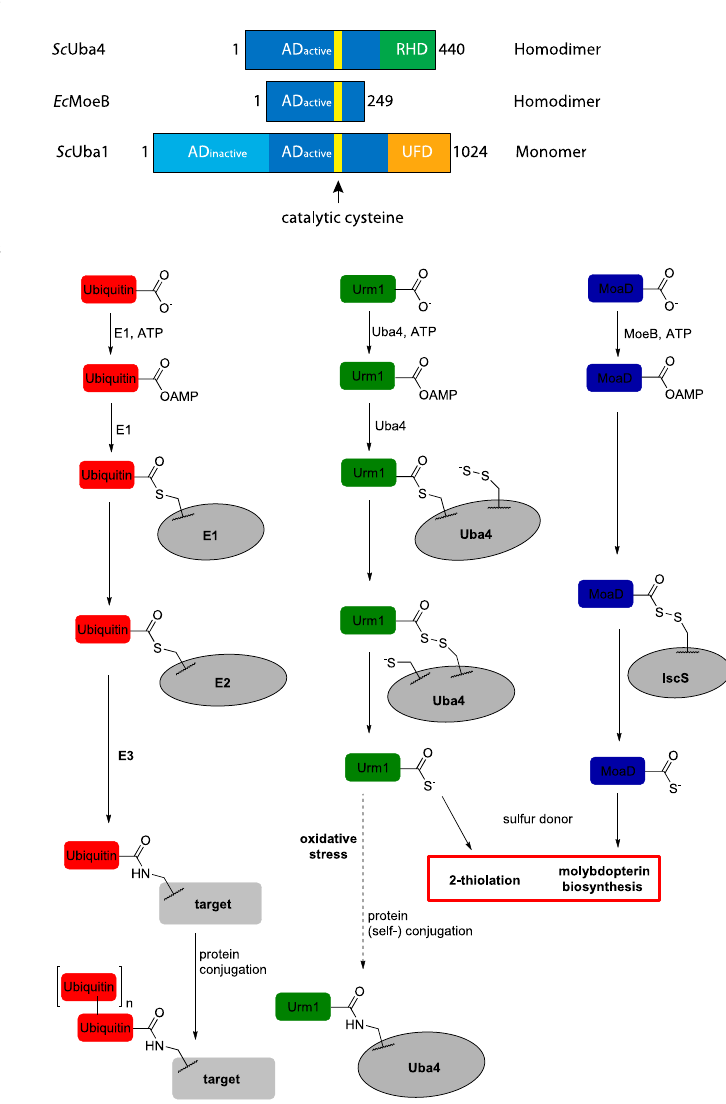
Figure 3. Domain overview of activating enzymes and mechanistical comparison of the Urm1-, ubiquitin- and MoaD-pathways. ( A ) Schematic representation of the Uba4 and Uba1 from S. cerevisiae and MoeB from E. coli [4,54,55]. The active adenylation domain is displayed in blue, whereas the inactive domain is shown in cyan. The rhodanese homology domain (RHD) and the ubiquitin fold domain (UFD) are colored in green and orange, respectively. The proteins are aligned according to the catalytic cysteine of the AD (yellow). Domain boundaries are indicated as well as the type of quaternary structure. ( B ) General mechanism of ubiquitin protein conjugation (left), the Urm1-Uba4 interaction (middle), and MoaD activation (right) (adopted from [49]). For details see main